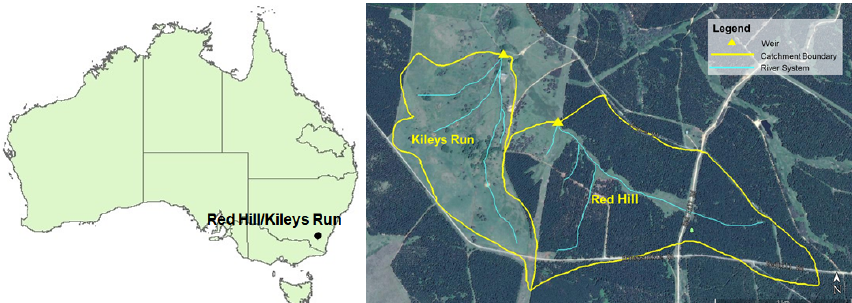
Figure 1. Location and satellite remote sensing image map of the Red Hill/Kileys Run catchments in New South Wales, Australia (© Google Earth).